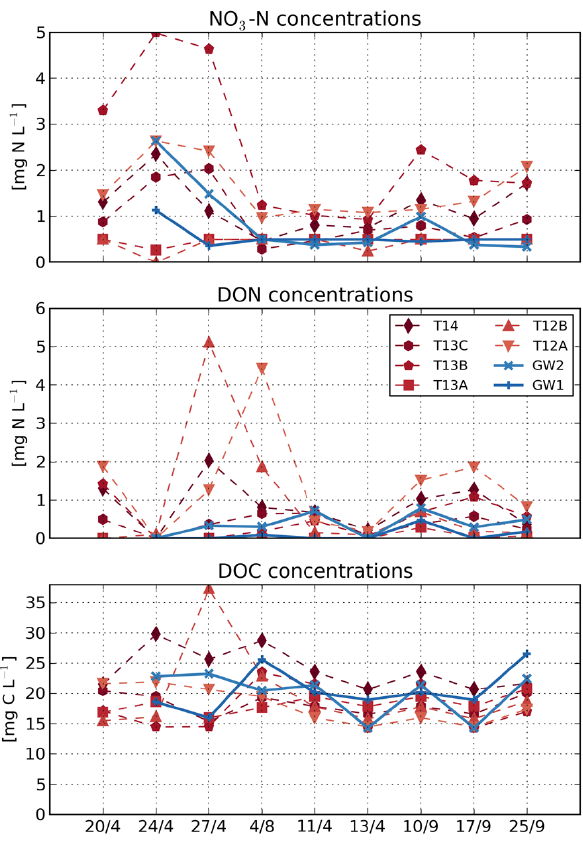
Fig. 6. Measured NO 3 -N, DON and DOC concentrations [mgl − 1 ] analysed in drains ( T ) and groundwater wells (GW) during the nine snap shot samplings. The given numbers of the drains refer to the previous in-stream sampling point; letters indicate the position of each drain between two points (A: first, B: second, C: